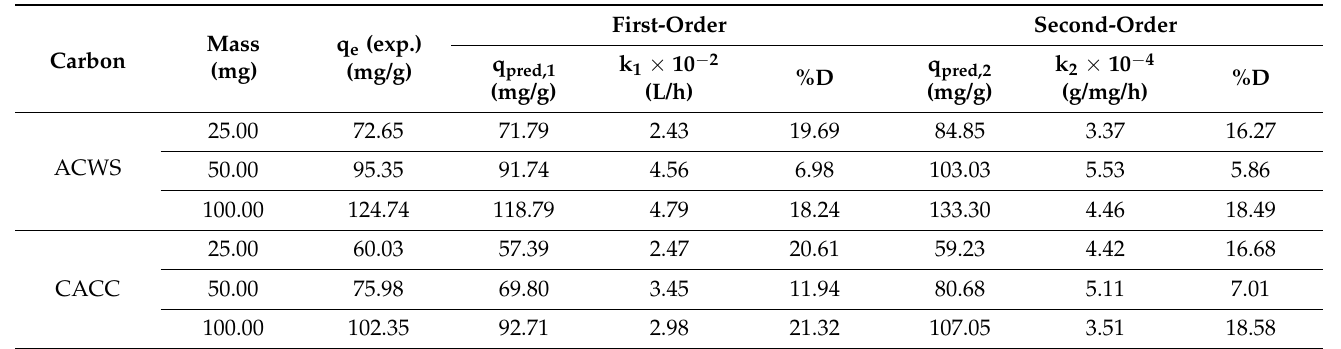
Table 5. Adsorption kinetics data of DPA on activated carbons ACWS and CACC after applying the first and second-order models.